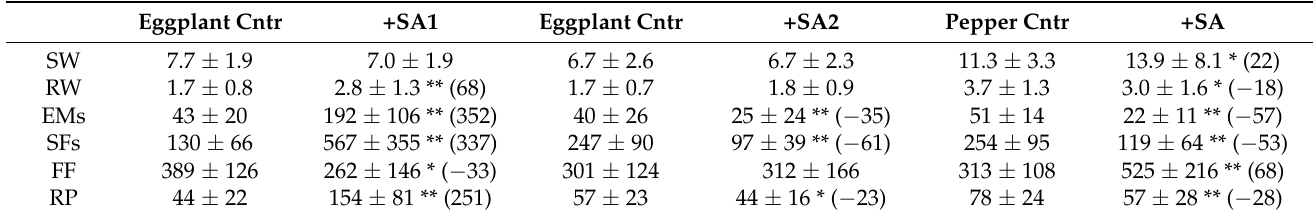
Table 4. Plant growth and infection factors detected 40 days after inoculation with RKN J2s (200 J2/plant), in untreated (cntr) and SA-treated eggplant and pepper. SA was applied to plants by soil drench in pots. Eggplants were treated with two ranges of doses (expressed as mg SA g − 1 plant fresh weight at treatment: SA1 0.8–1.7, SA2 3.0–6.5; pepper with SA 1.5–1.8). Plant growth was assessed by shoot (SW) and root weights (RW) expressed in grams; nematode infection severity is indicated by egg mass (EMs) per root system, sedentary forms (SFs) per root system, female fecundity (FF), and reproduction potential (RP). Mean values ± standard deviations obtained from untreated and SA-treated tomato plants were differentiated by a paired t -test (* p < 0.05; ** p < 0.01). In parentheses, significant differences are expressed in